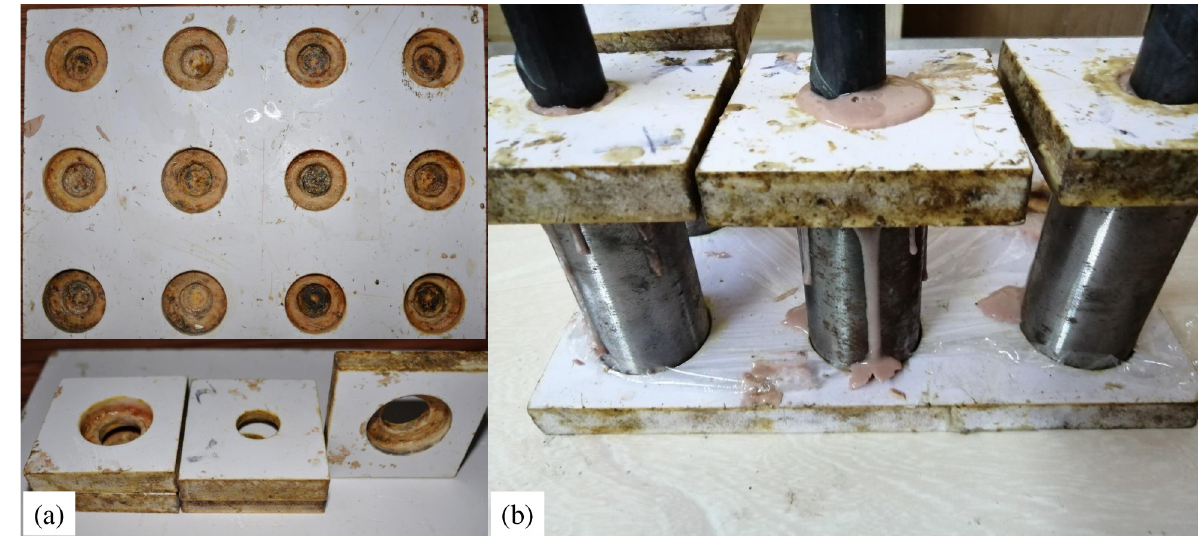
Fig 6. Centering device and bolting